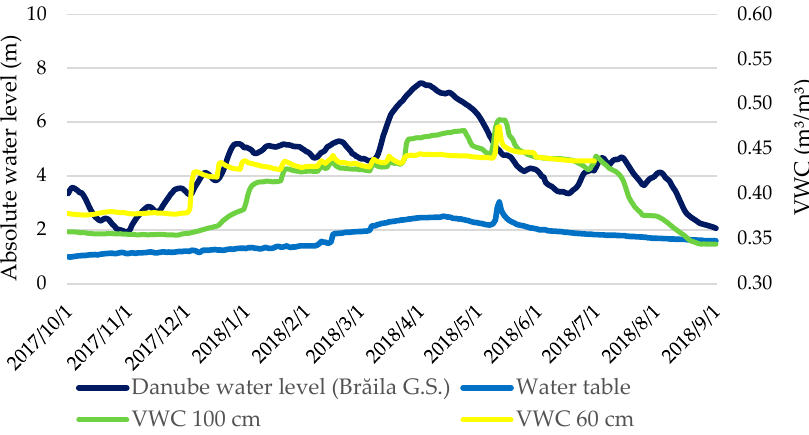
Figure 9. Danube water level, water table and soil moisture variation (2017–2018).